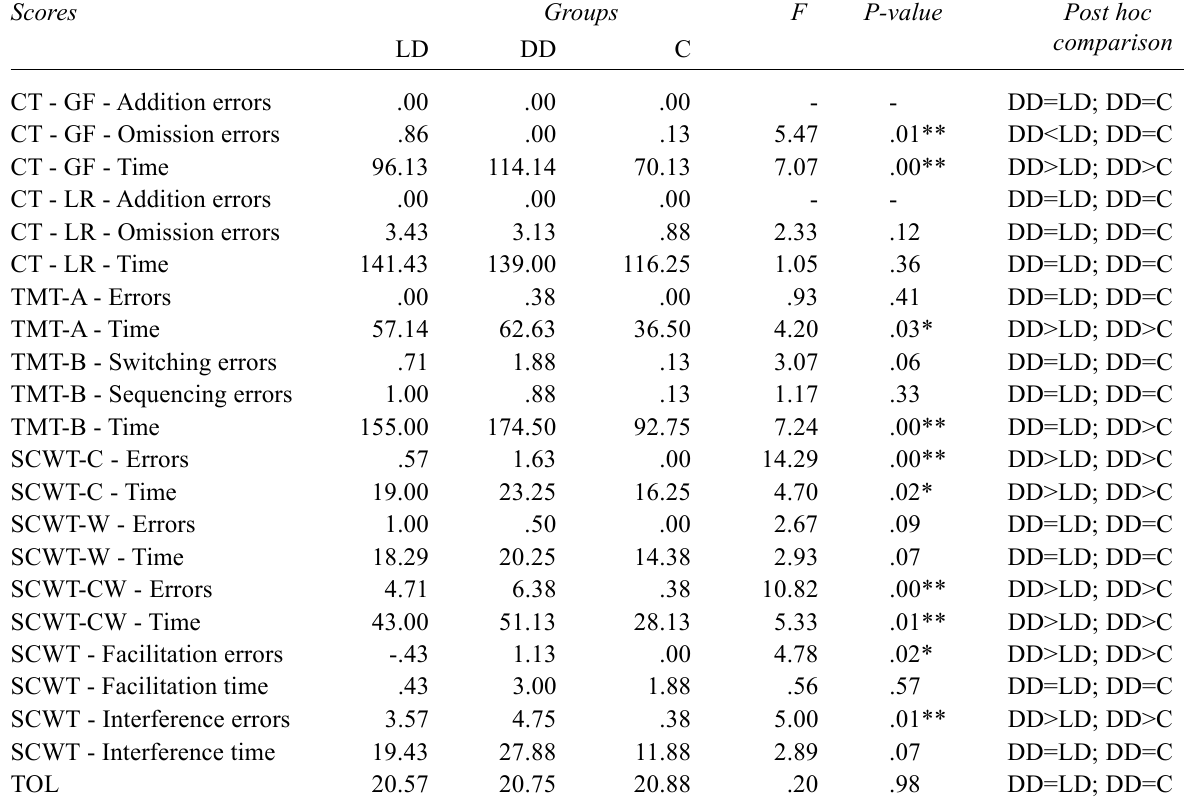
Comparison of Average Test Scores among Groups and ANOVA Results, including F and p Values and Bonferrori Post Hoc